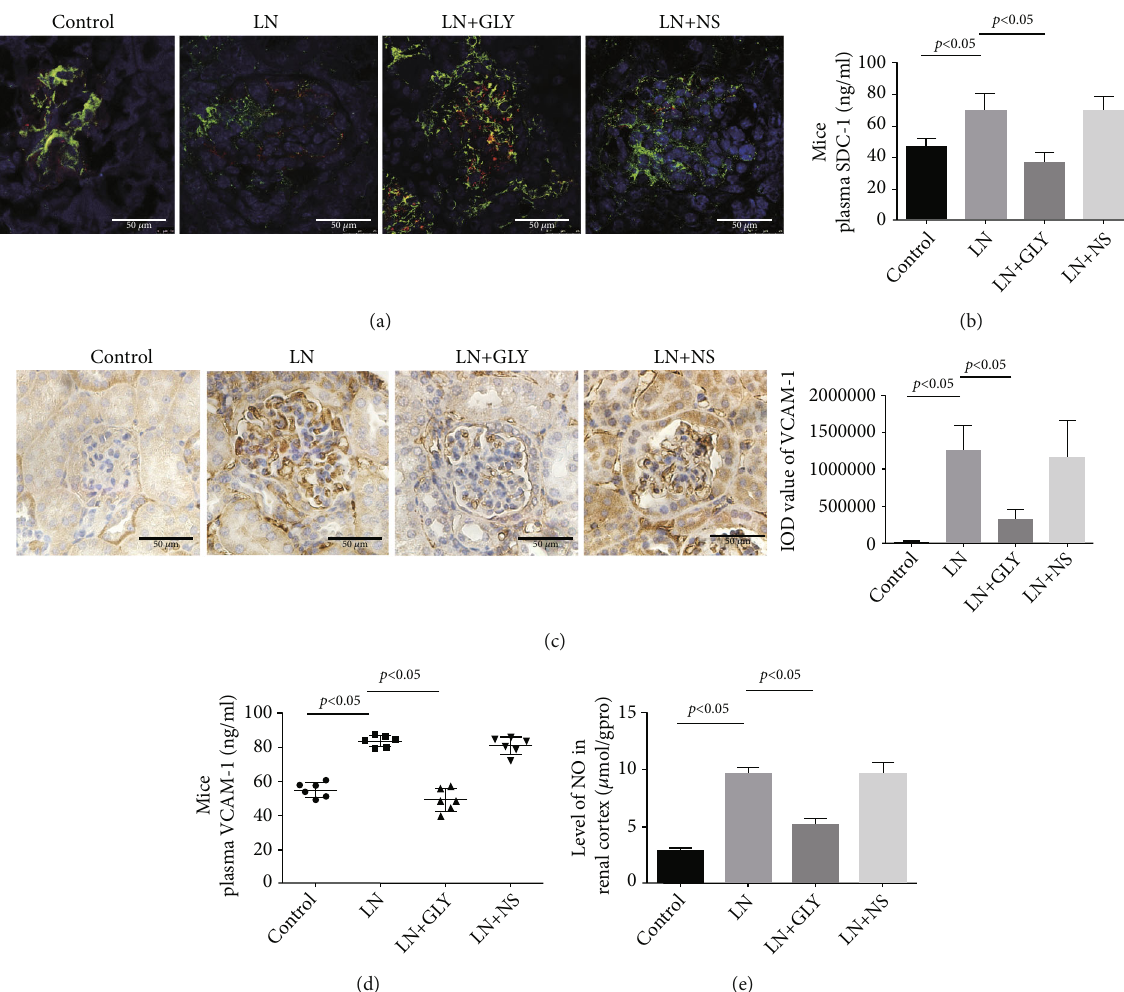
Figure 5: GLY treatment improved the injury of GECs in MRL/lpr mice. (a) Colocalization of CD31 (green) and SDC-1 (red) in mouse glomeruli cells was detected by IF staining. (b) The level of mouse plasma SDC-1 measured by ELISA ( n = 6 ). (c) IHC showed the expression of VCAM-1 in mouse glomeruli. (d) The level of VCAM-1 in mouse plasma assessed by ELISA ( n = 6 ). p < 0 : 05 vs. LN group. (e) The level of NO in mice renal cortex ( n = 6